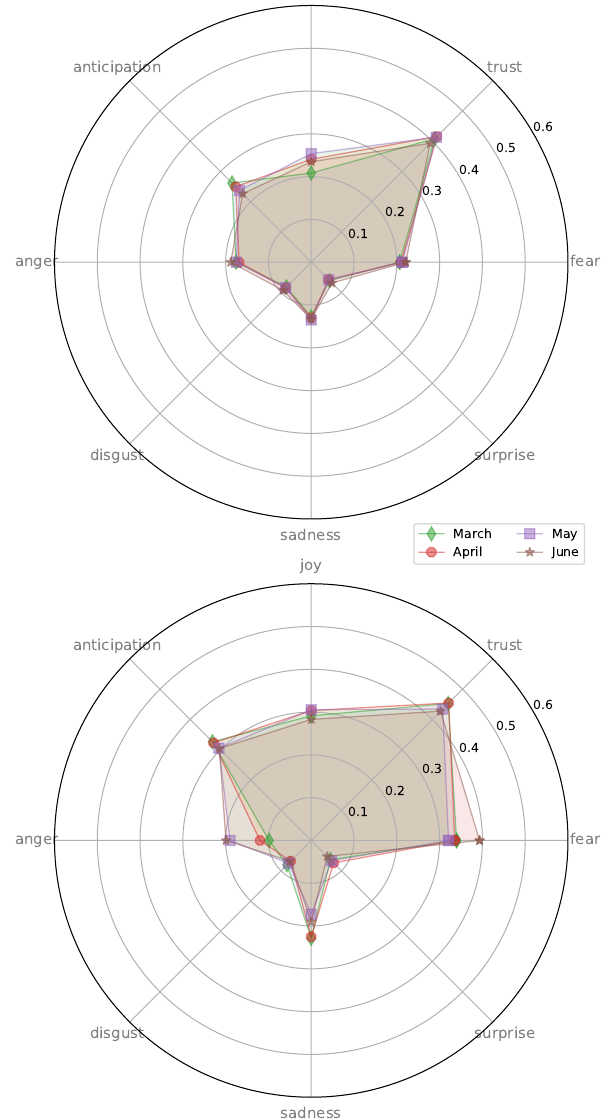
Figure 19. Radar plot of most expressed emotions in UK per month for both 2019 ( top ) and 2020 ( bottom )